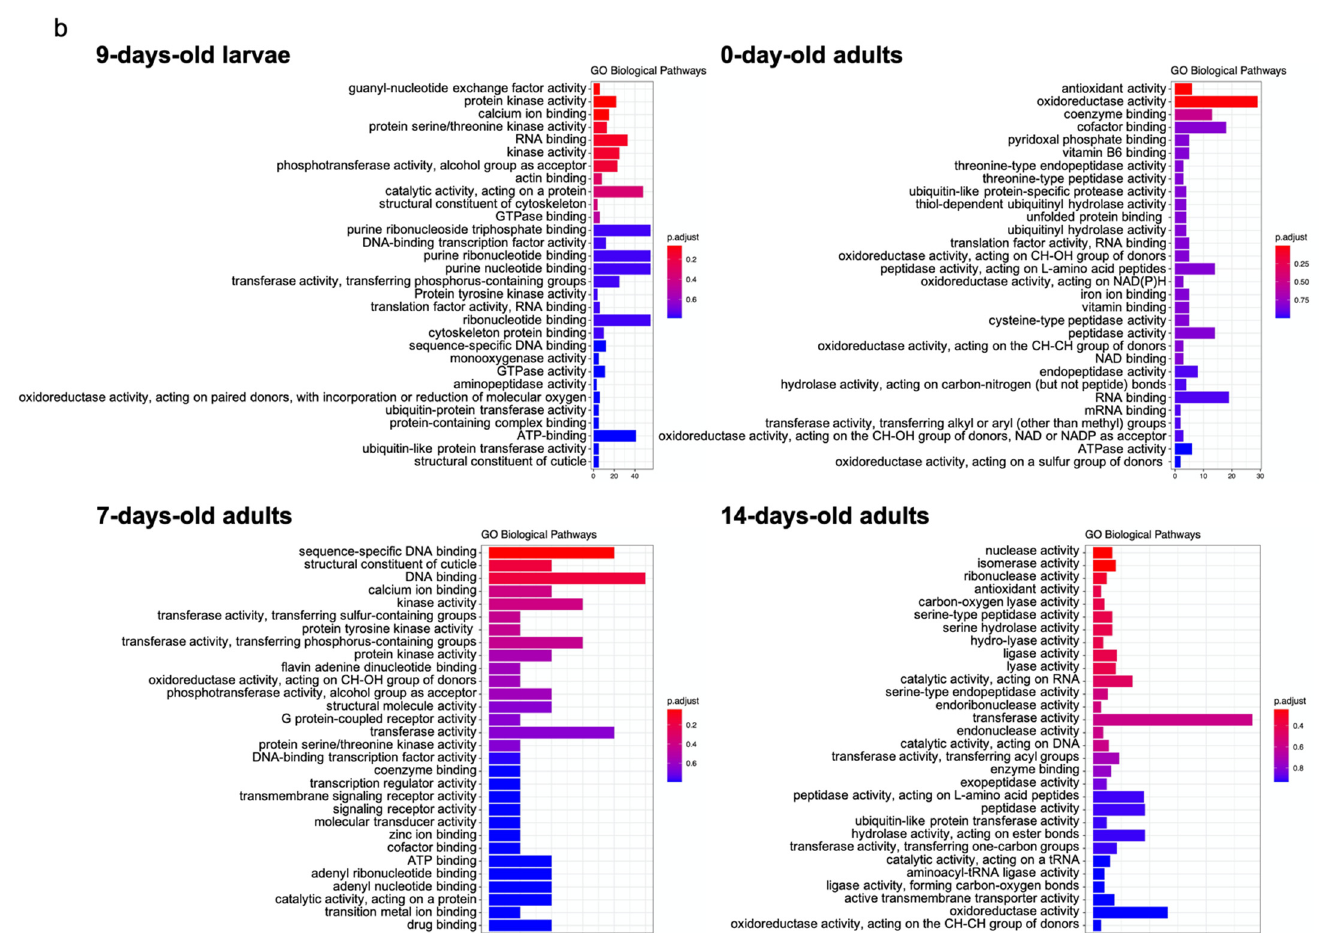
Figure 1. GO biological pathways of ( a ) upregulated and ( b ) downregulated DEGs among different imidacloprid treatments of 9-day-old larvae, 0-day-old adults, 7-day-old adults, and 14-day-old adults. X-axis: number of genes; Y-axis: GO terms; p.adjust: the adjusted p value of identified GO terms; bar color from red to blue represents the adjusted p value from low to high.